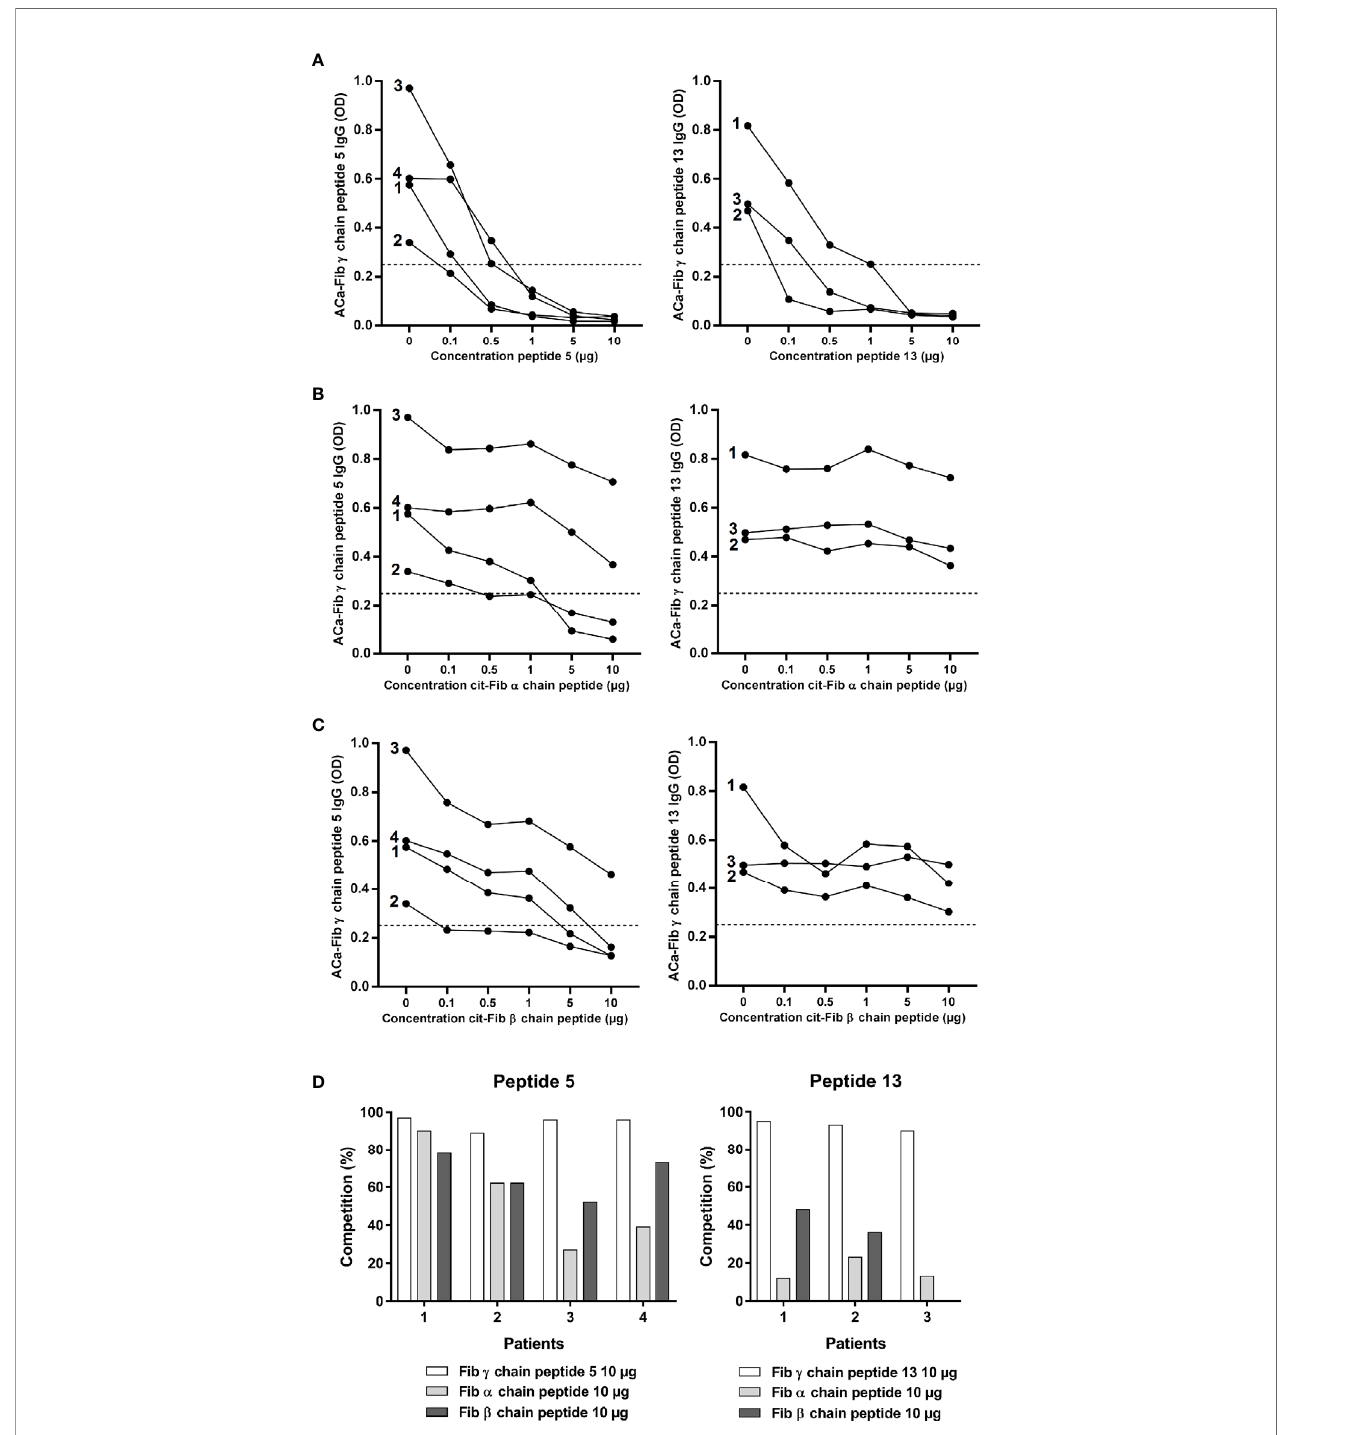
FIGURE 3 | Cross reactivity assay of carbamylated g chain of fi brinogen peptides 5 and 13 with major epitopes of the anti-citrullinated fi brinogen response. (A) ELISA inhibition test of carbamylated g chain of fi brinogen peptides 5 or 13 with their corresponding peptides at increasing concentrations (0, 0.1, 0.5, 1, 5 or 10 µg/mL). (B) ELISA inhibition test of carbamylated g chain of fi brinogen peptides 5 or 13 with an immunodominant epitope of citrullinated fi brinogen a chain at increasing concentrations (0, 0.1, 0.5, 1, 5 or 10 µg/mL). (C) ELISA inhibition test of carbamylated g chain of fi brinogen peptides 5 or 13 with an immunodominant epitope of citrullinated fi brinogen b chain at increasing concentrations (0, 0.1, 0.5, 1, 5 or 10 µg/mL). (D) Percentages of inhibition for each peptide. ELISA tests expressed as OD (Optical Density) at 450 nm. Sera highly positive for carbamylated g chain of fi brinogen peptide 5: n=4; sera highly positive for carbamylated g chain of fi brinogen peptide 13: n=3. ACa-Fib g chain, anti-carbamylated fi brinogen g chain